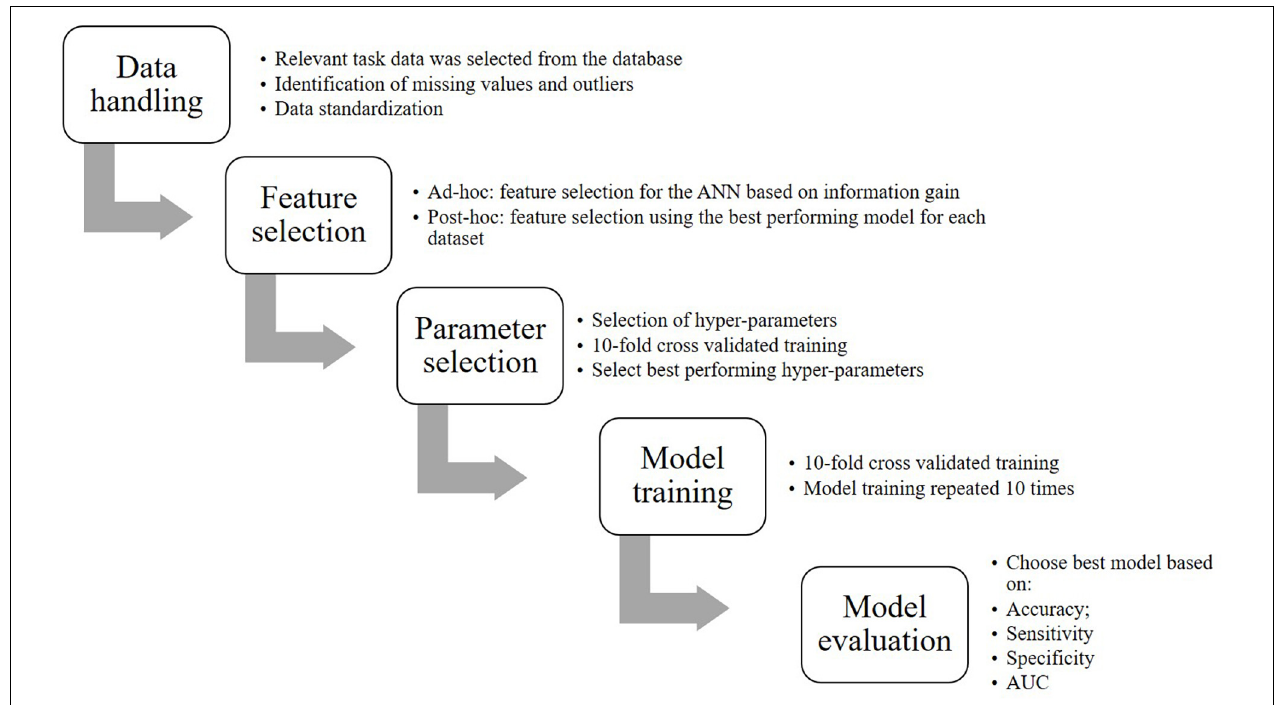
FIGURE 1 | Flowchart of the classification